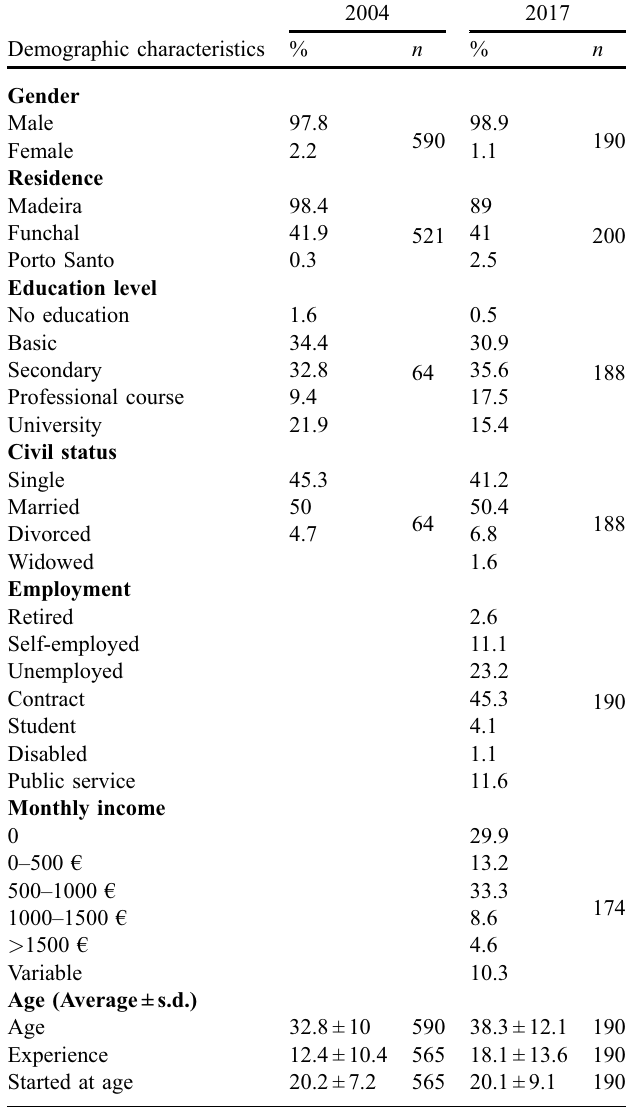
Table 1. Comparison of spear fi shers ’ demographic characteristics between 2004 and